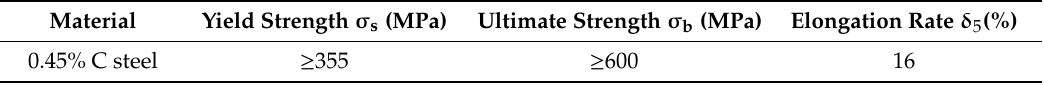
Table 1. Mechanical properties of 0.45% C